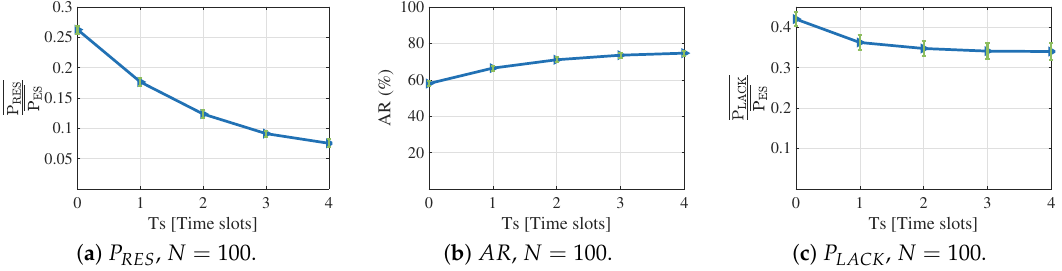
Figure 18. Example of performance evaluation of F AST T S for a random case in a large-scale scenario. Parameters: According to Case E of Table 5, for N = 100 and with numPart = 30. Table 10. Average values of metrics and running time for F AST T S in large-scale scenarios for T s = 4. P LACK Parameters P RES P ES P